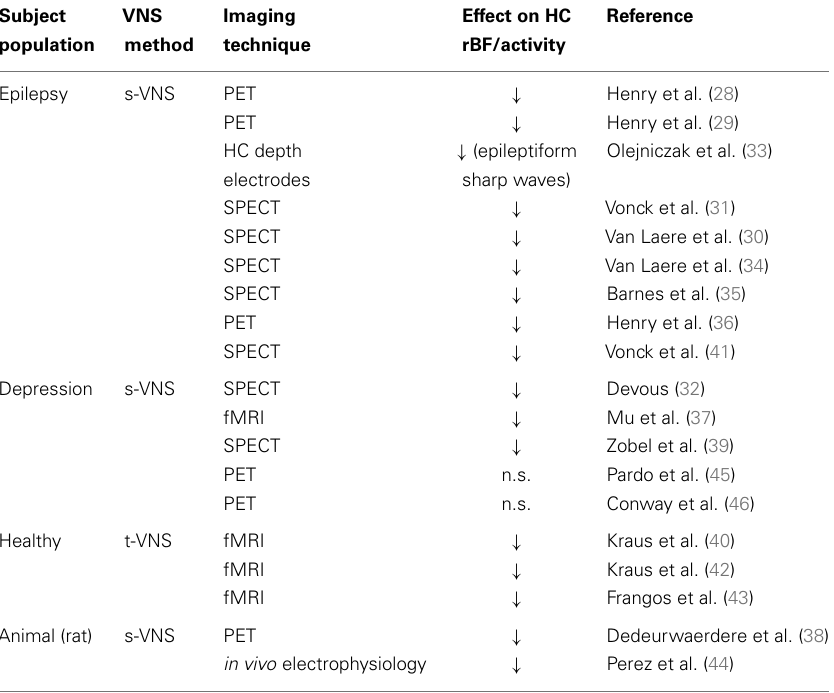
Table 1 | Studies that have demonstrated effects ofVNS on hippocampal activity